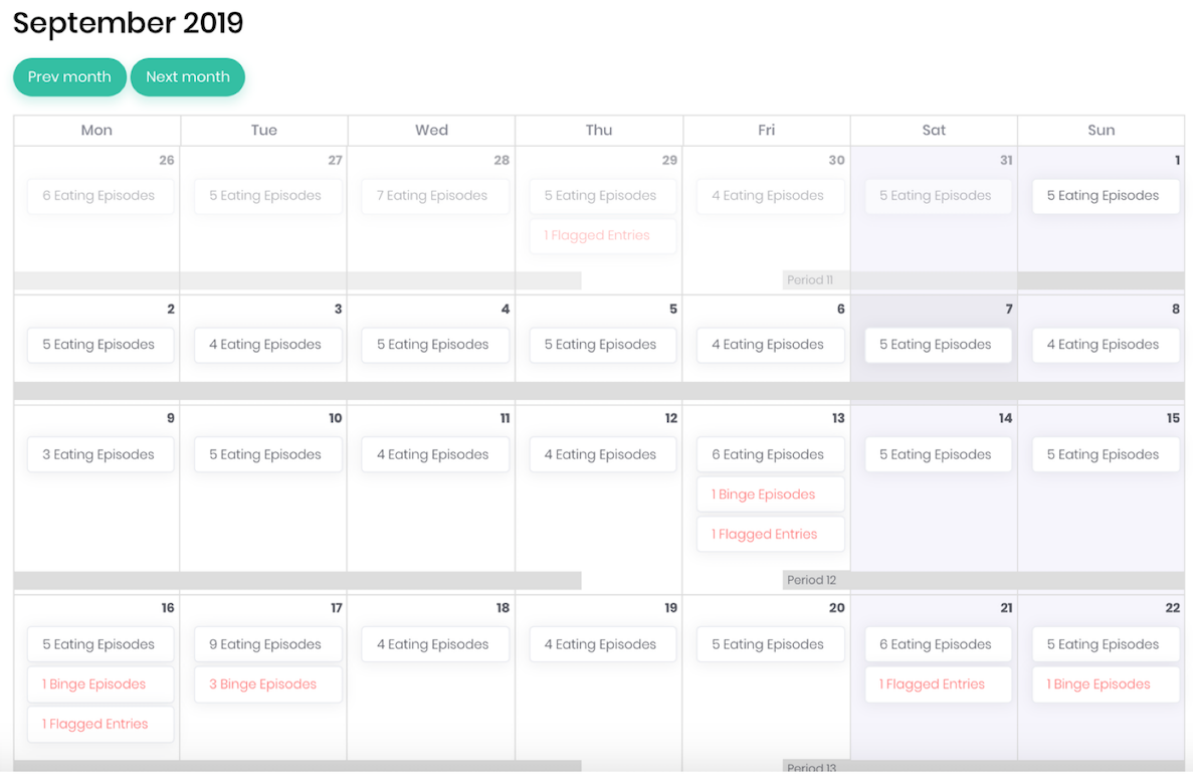
Figure 5. Calendar feature of the CBT+